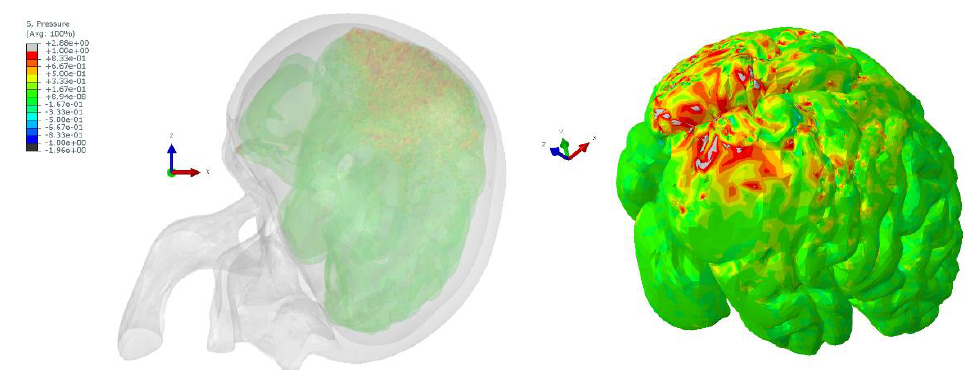
Figure 13. Contour plot of hydrostatic pressure (MPa) for the brain for the head–steering wheel impact at 396 ms—visible contrecoup phenomenon on the occipital region.